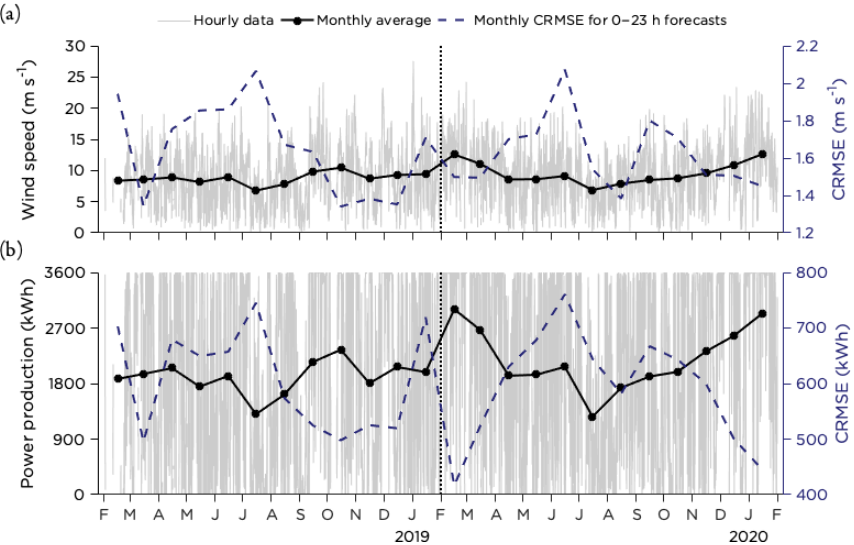
Figure 3. Overview of hourly data and monthly averages of (a) wind speed and (b) theoretical power production at Utö during the 2 years of measurements. Also CRMSE for wind speed and power production forecasts from AROME are presented.